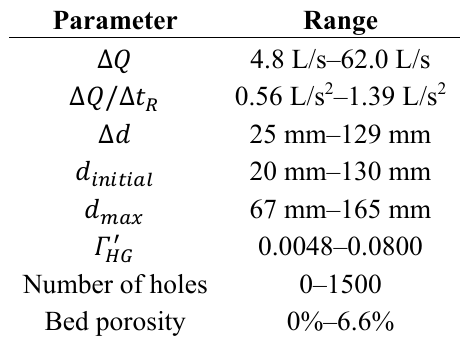
Table 1. Experimental range of hydrograph